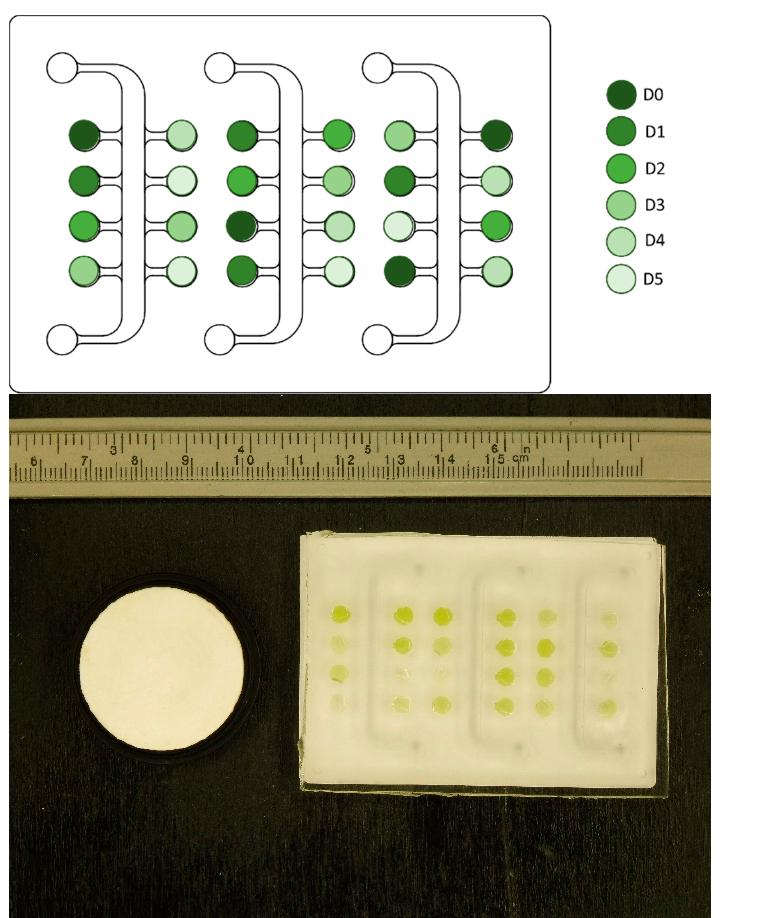
Figure 1. ( a ) Representation of the scheme of sample dilution in the µPBR used for digital image acquisition [6]. Each well has a 4 mm diameter and 2 mm height. The dilutions of the culture from the PBR were inoculated in random positions. ( b ) Example of a raw image of the µPBR to be processed to extract features for the prediction model. The image corresponds to experiment HLB, day 4.